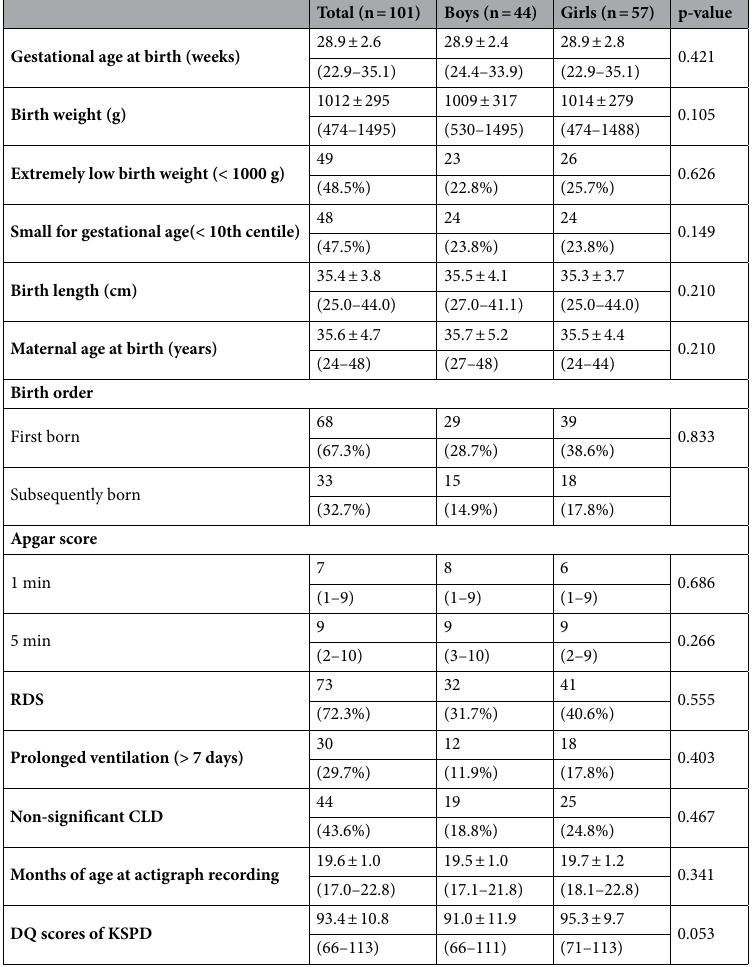
Table 1. Characteristics of participants by gender (median for Apgar score; mean ± s.d. or number for other variables). RDS respiratory distress syndrome, Non-significant CLD non-significant chronic lung